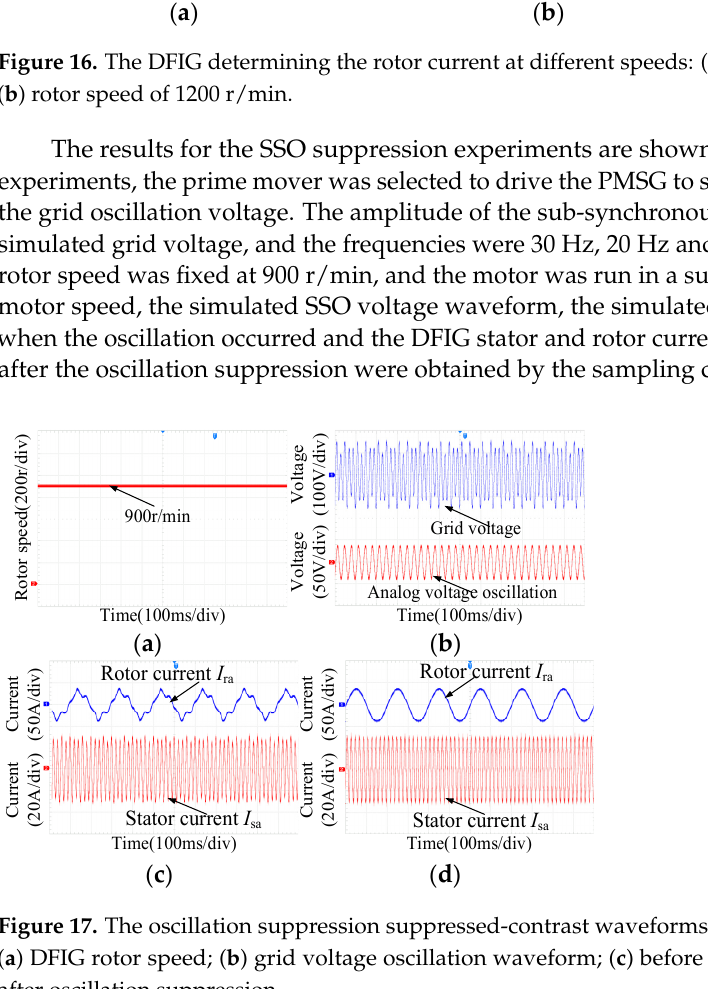
Figure 18. The oscillation suppression suppressed-contrast waveforms at SSO frequency of 20 Hz: ( a ) DFIG rotor speed; ( b ) grid voltage oscillation waveform; ( c ) before oscillation suppression; ( d ) after oscillation suppression.